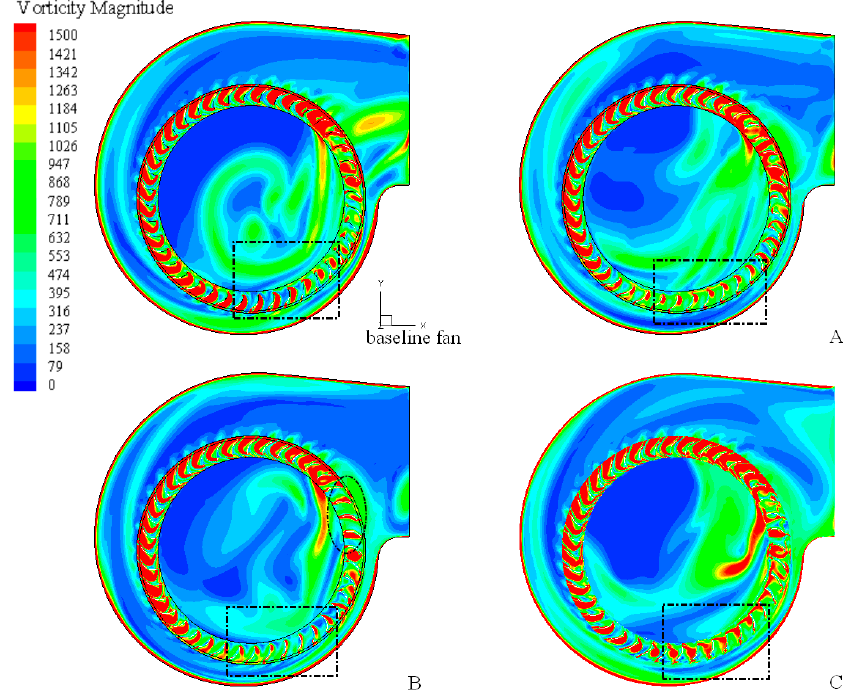
Figure 17. Contour of vorticity magnitude for the z = 35 mm plane at a rated flow rate Q / Q n = 1.000: ( A ) model-A; ( B ) model-B; ( C )